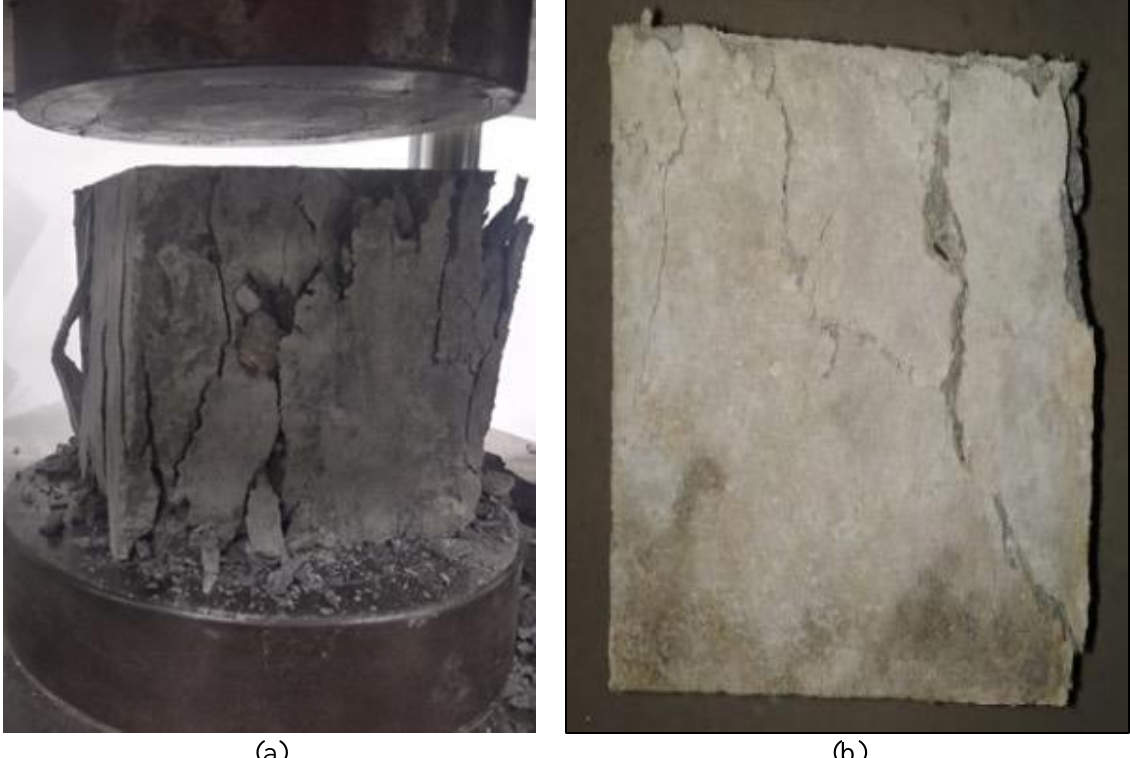
Fig. 6. Specimen after Compression failure (a) Plain Concrete (b) JRC4 (JF 0.1% & RH 10%).